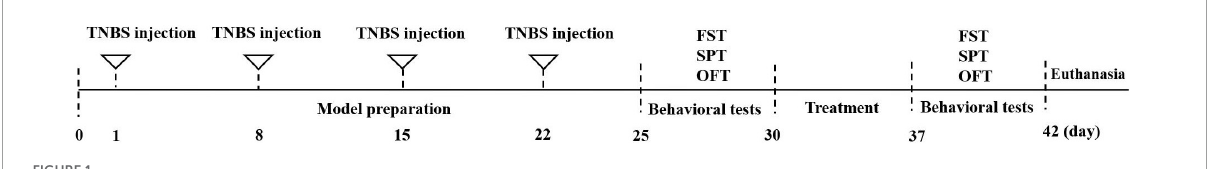
FIGURE1 Experimental